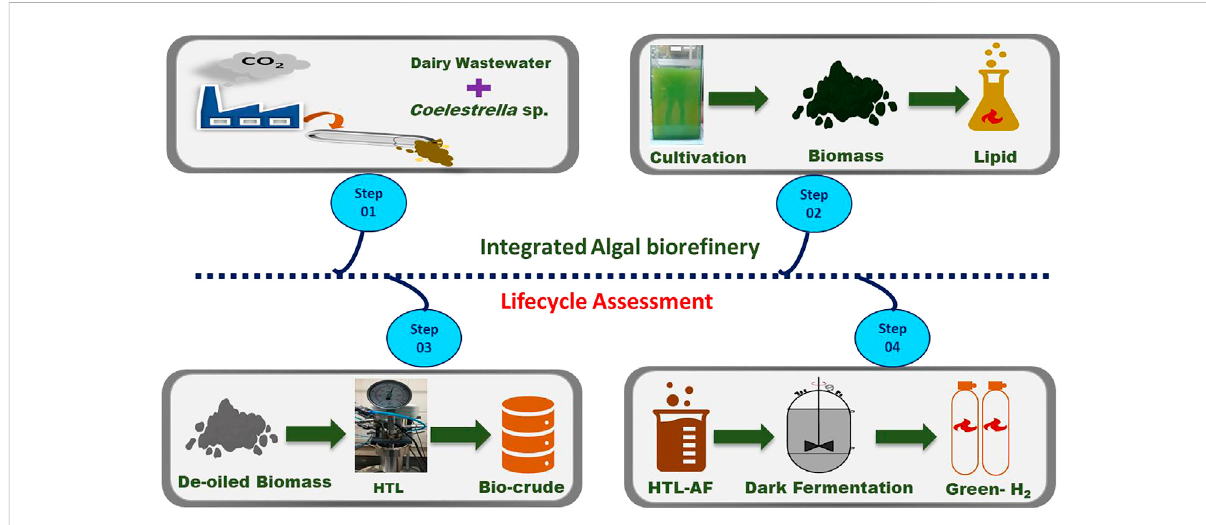
(cid:129) Coelestrella sp. SVMIICT5 was used for dairy wastewater treatment and nutrient recovery (cid:129) Photosynthetic transition and biomolecular yields during microalgae cultivation were studied (cid:129) Bio-crude, aqueous fraction, and energy pro fi les during HTL were studied (cid:129) A higher bio-crude fraction (52%) was observed in H-HTL at 250 ° C (cid:129) The bioprocess (HTL-AF) resulted in 231 ml/g of bio-H with 63% TOC removal (cid:129) Microalgae with a semi-synthesis approach allowed